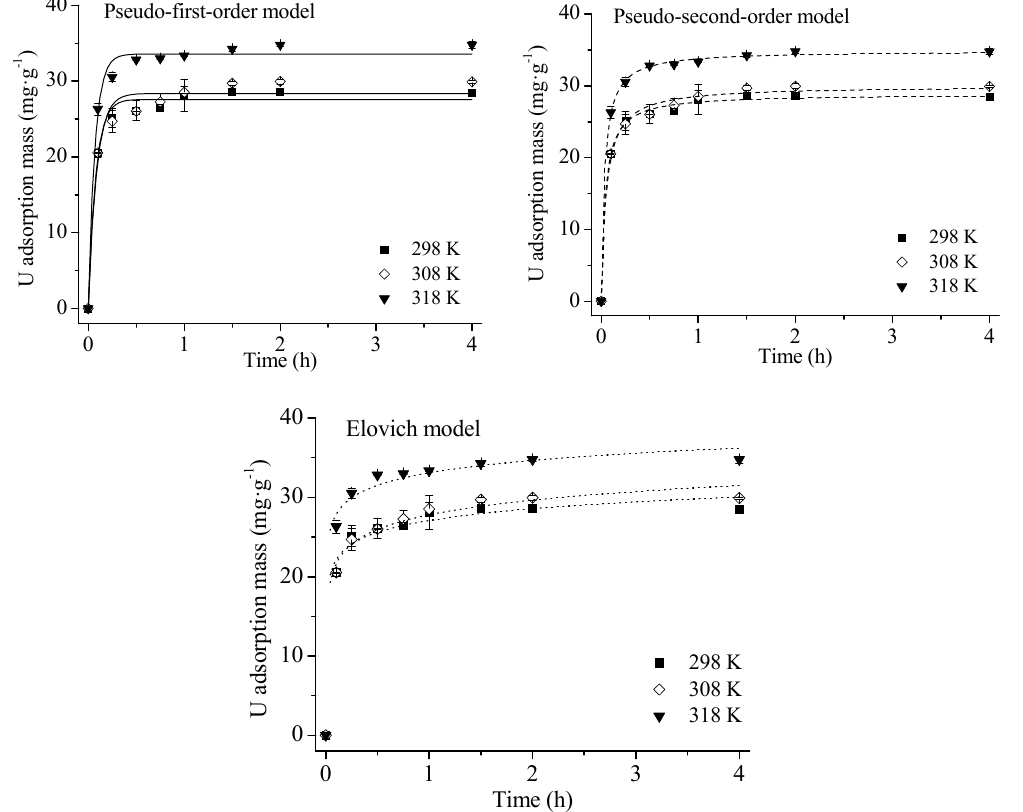
Figure 2. Kinetic models for U adsorption onto HA at different temperatures. Experimental conditions: adsorbent mass: 20 mg; solution volume: 30 mL; U(VI) concentration: 60 mg/L; contact time: 0.1, 0.25, 0.5, 0.75, 1, 1.5, 2 and 4 h; initial pH = 3.0; end pH: 2.70–2.90. Table 2. Parameters of kinetic models for U(VI) adsorption onto HA.